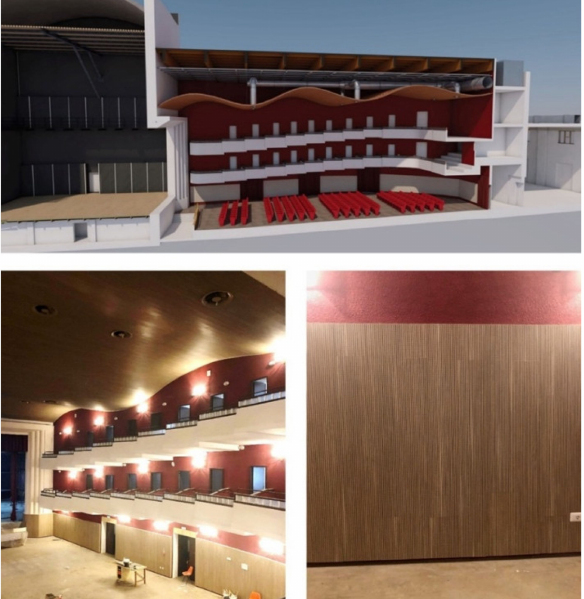
Figure 4. Combo 02—Wooden roof with false ceiling and acoustic panels on the walls.